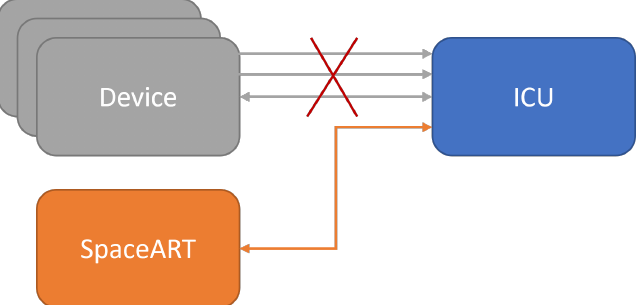
Figure 2. SpaceART EGSE emulator-Instrument Control Unit (ICU) test